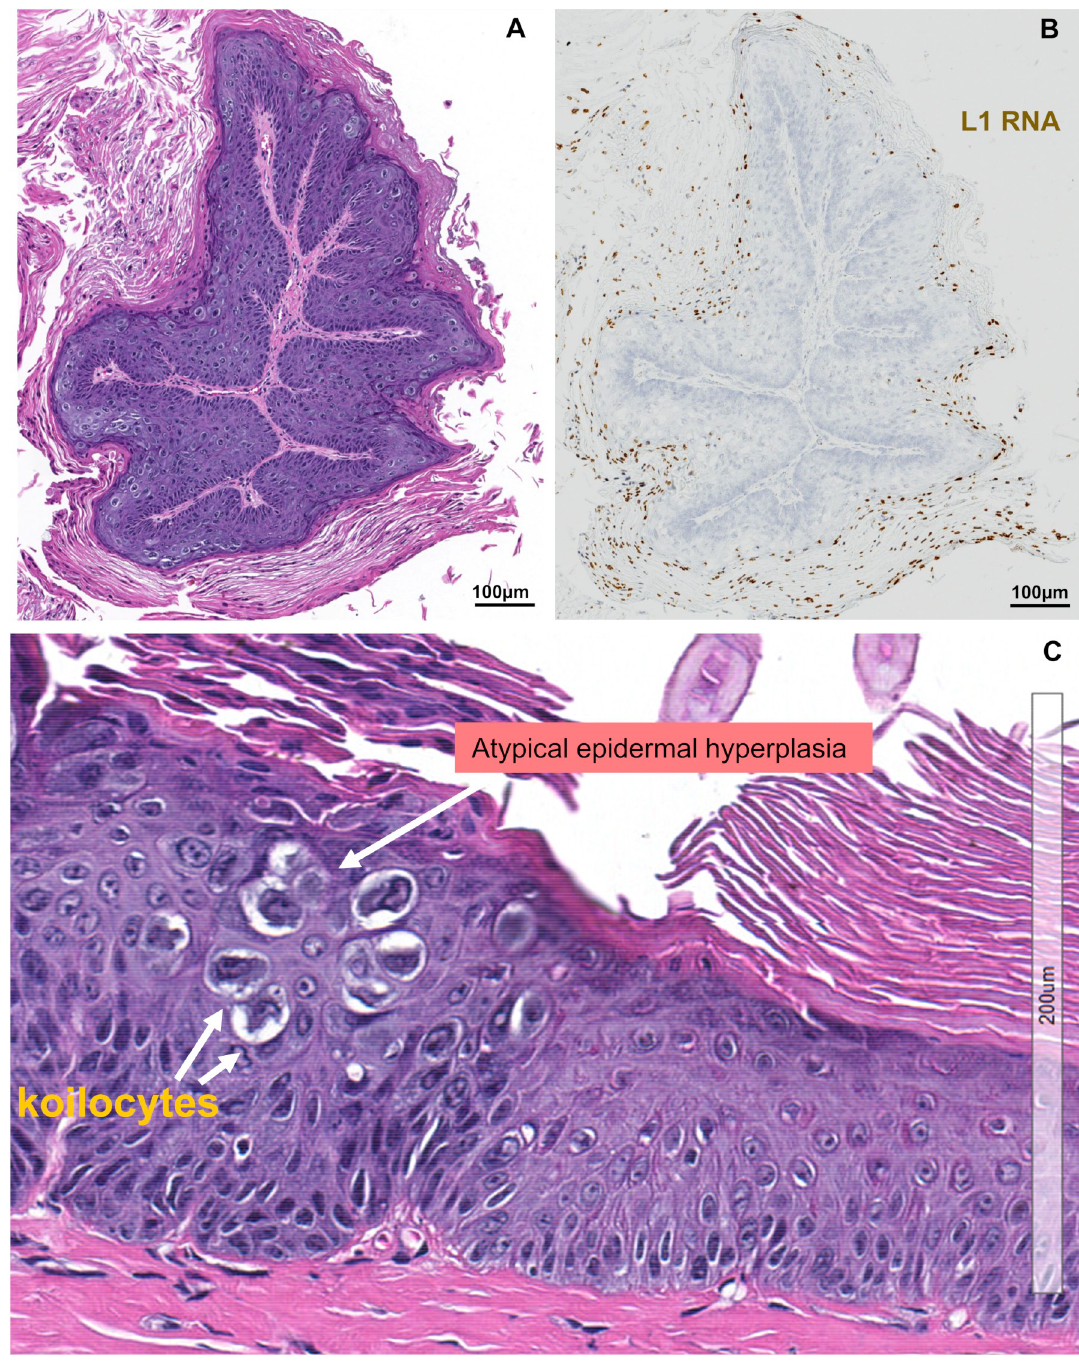
Fig 1. MmuPV1 induced papillomas express viral L1 RNA. A, H&E staining of a thin section of a classic papilloma showing the inner layer stroma, intermediate layer of hyperplastic and koilocytotic epithelial cells, and outer cornified, keratinized layer. This tissue was collected from a female mouse muzzle tumor after six months of MmuPV1 inoculation. B, RNA in situ hybridization (RNA-ISH) of MmuPV1 L1 from a serial section of the same MmuPV1-infected papilloma which was detected by an RNAscope assay with a MmuPV1-specific L1 probe. The tissue was DNase-treated to remove all viral DNA before hybridization. This image shows that MmuPV1 L1 RNA (yellow brown color) is preferentially expressed in the terminally differentiated keratinocytes and the keratinized cells in the outer layer. C, An enlarged area of the section in panel A showing atypical epidermal hyperplasia, koilocytes and hyperkeratosis.